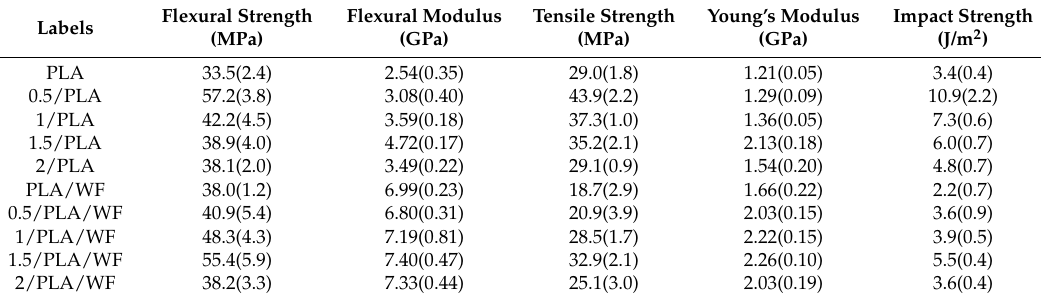
Table 3. Mechanical properties of virgin and OMMT-modified PLA and the